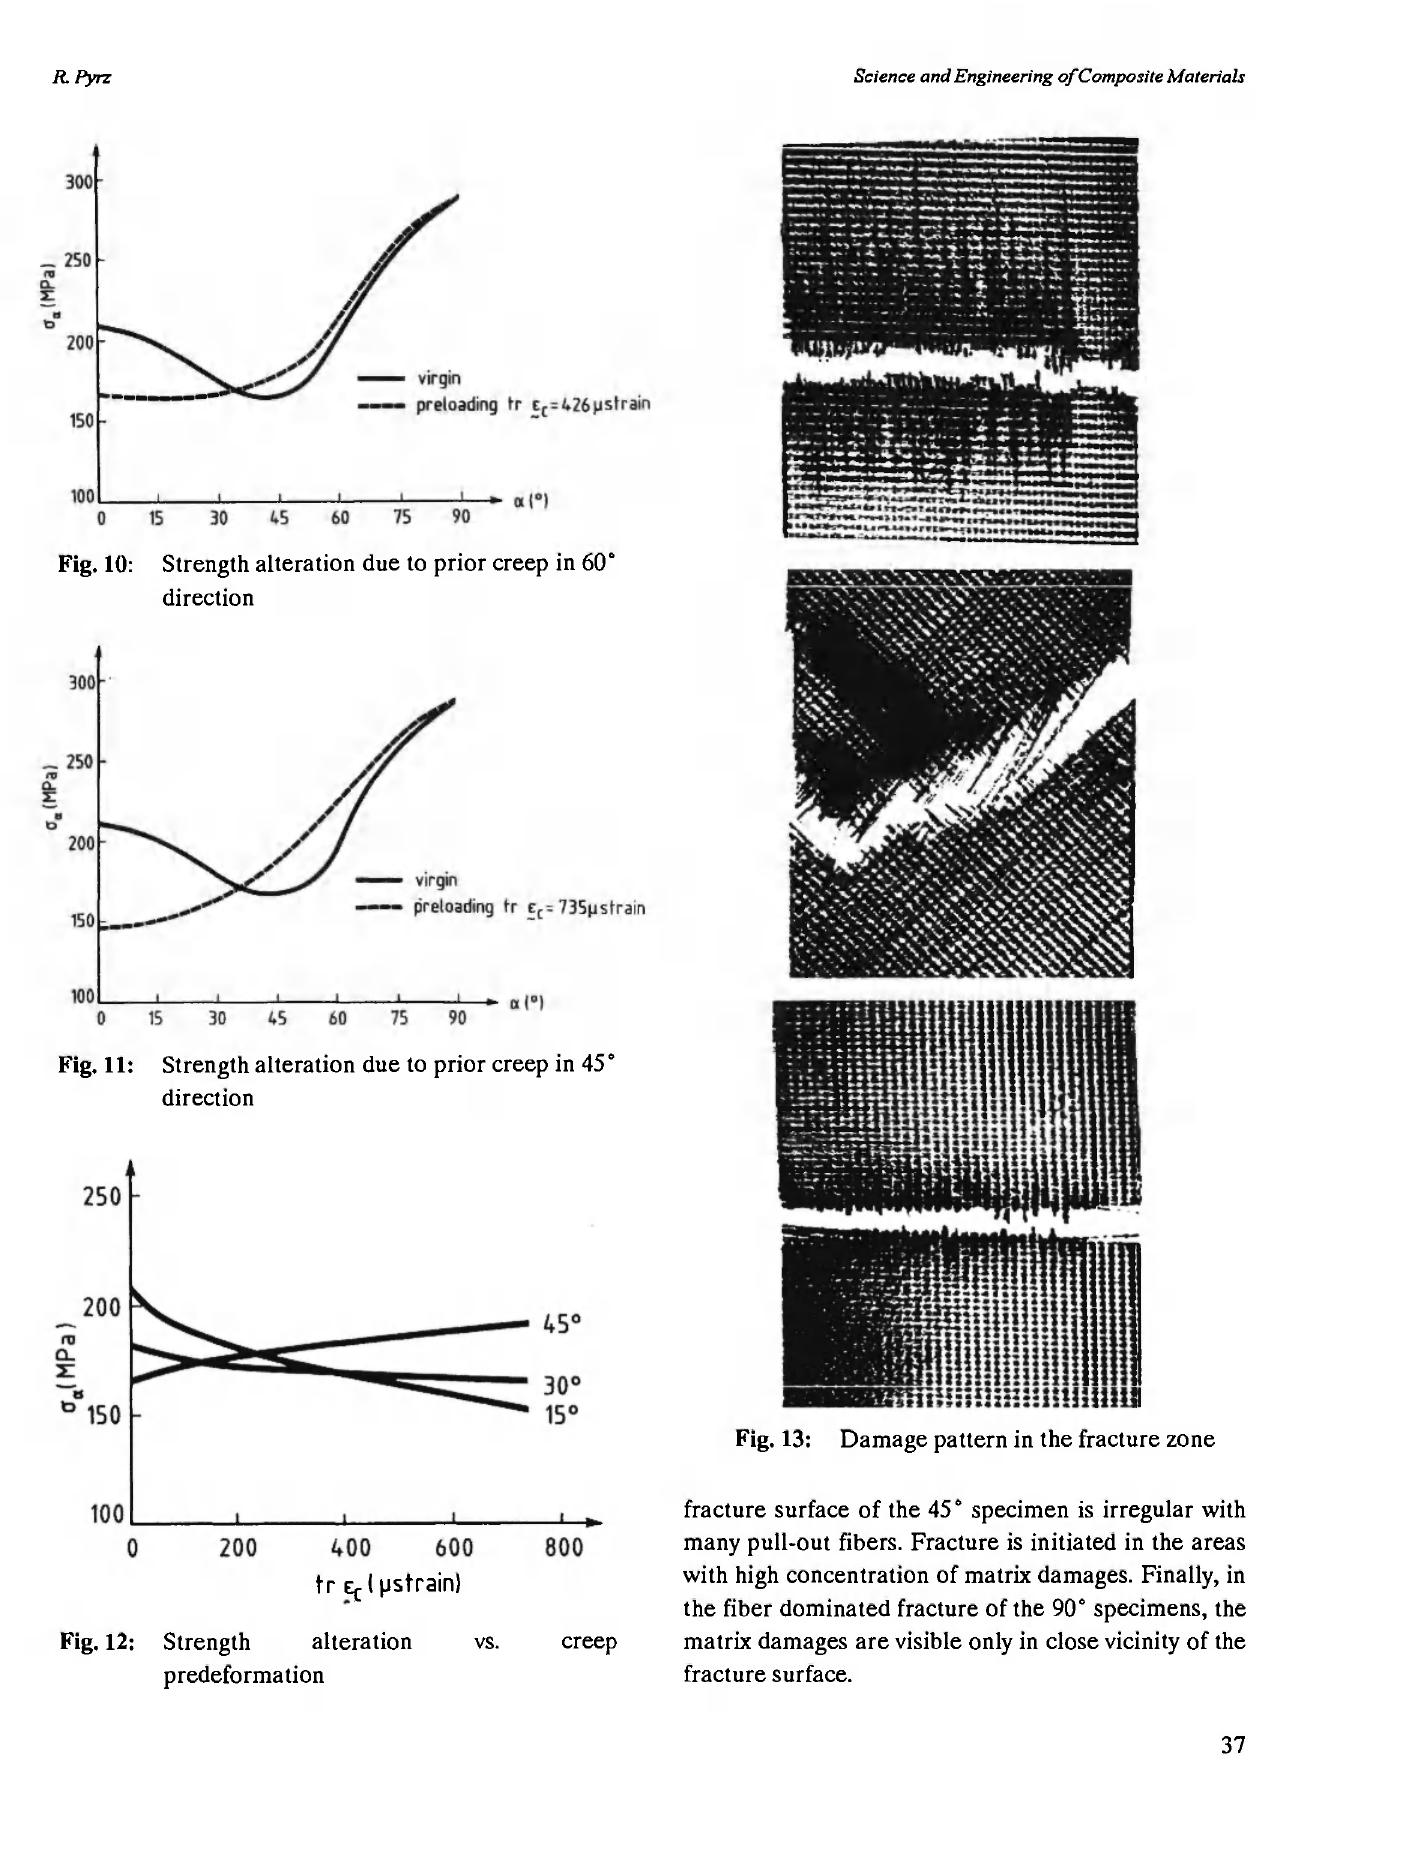
Fig. 10: Strength alteration due to prior creep in 60° direction